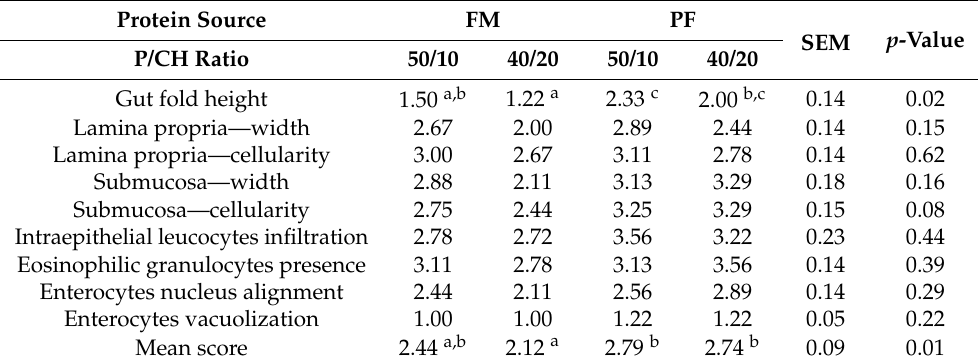
Table 3. Details of the score-based evaluation of the midgut histology of gilthead seabream fed the experimental